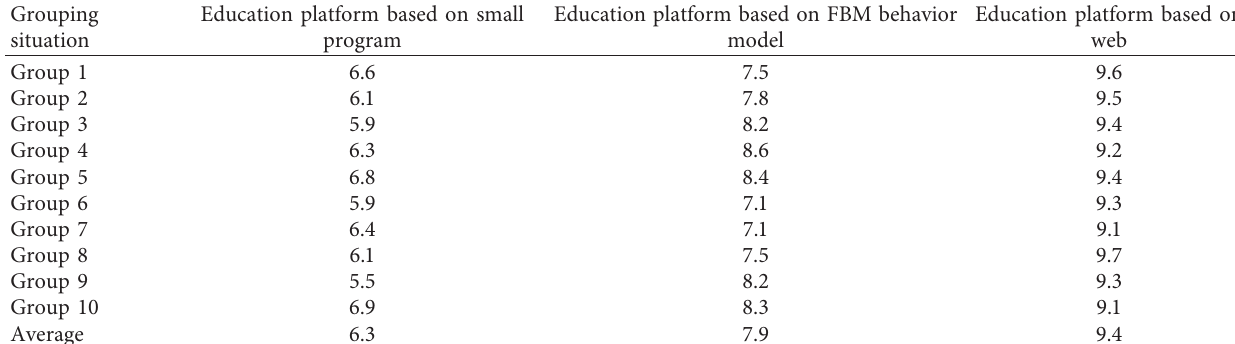
Table 5: Satisfaction test